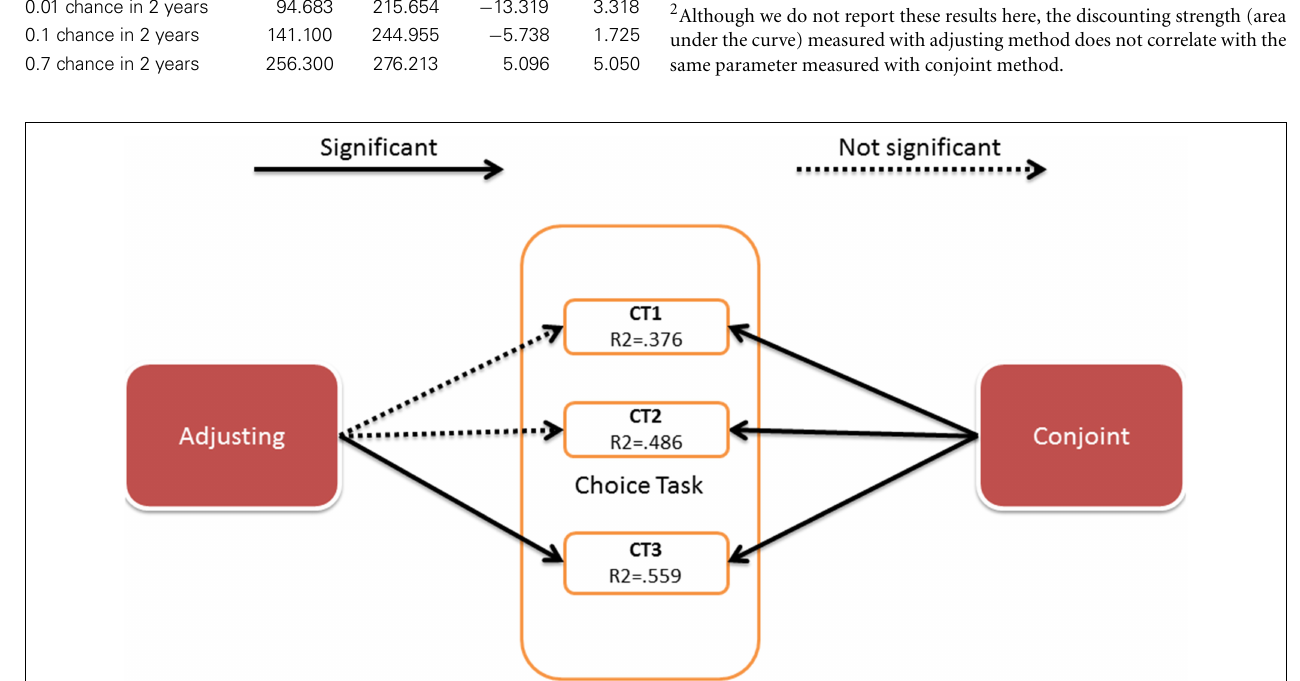
FIGURE 5 | Results of the binary logistic regression. Details of the analysis are presented in the Appendix 2 (Supplementary Material).